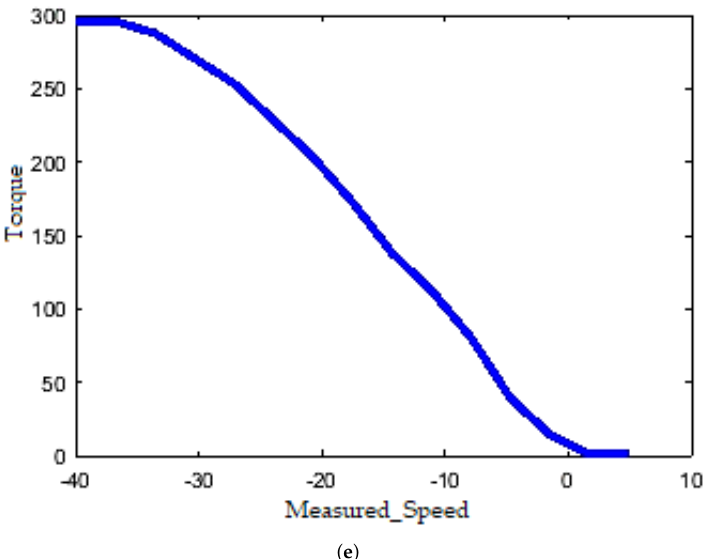
Figure 11. Mamdani fuzzy logic controller Simulink environment: ( a ) fuzzy logic designer; ( b ) input membership function; ( c ) output membership function; ( d ) rule viewer; and ( e ) output surface of